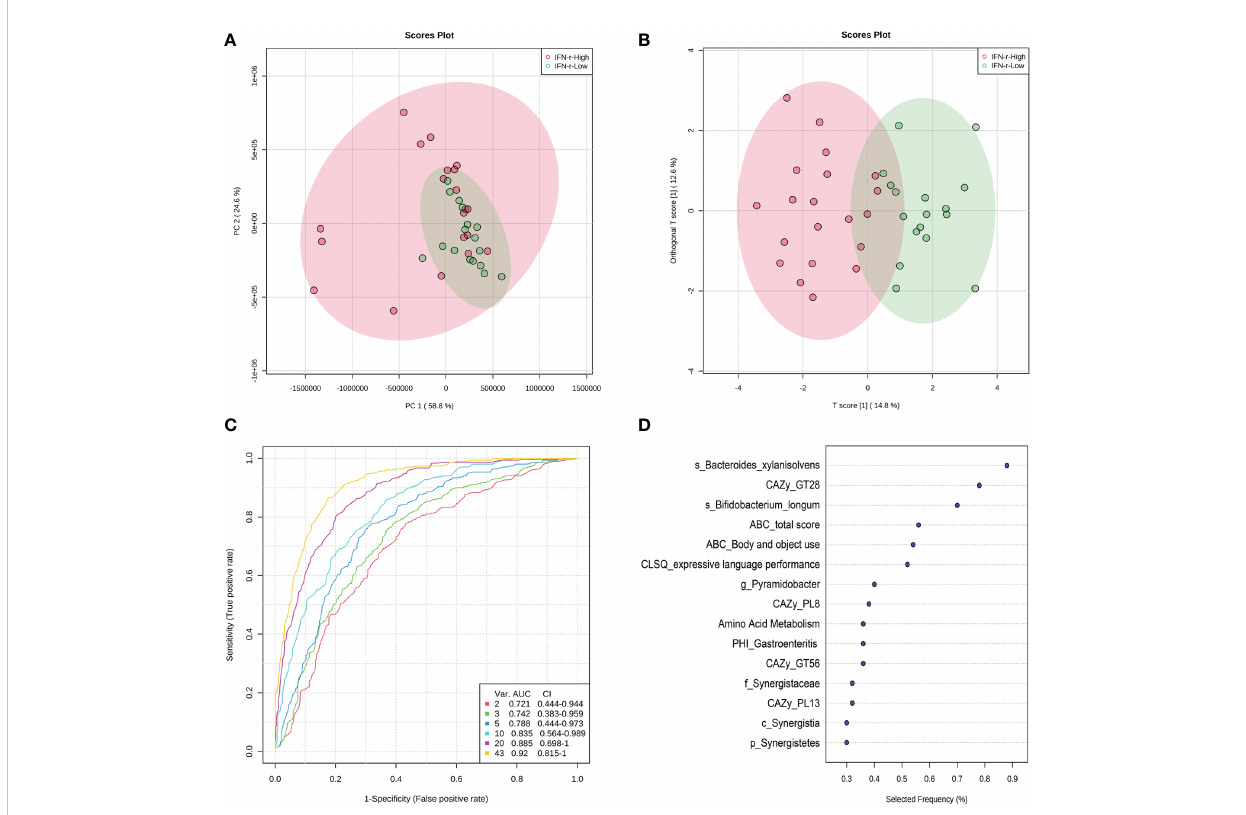
FIGURE 8 Scores plot of multivariate analysis and potential discriminating features analysis using random forests algorithm. (A) Principal component analysis (PCA) scores plot and (B) Orthogonal partial least-squares discriminate analysis (OPLS-DA) scores plot of ASD children in the IFN- g -Low (green) and IFN- g -High (red) groups. Each point represents the score of a single individual. The shaded areas indicate the 95% con fi dence ellipse regions for each group. (C) ROC curves from different multivariate models using different number of features. (D) The top 10 signi fi cant discriminating features ranked based on their frequencies of being selected during cross